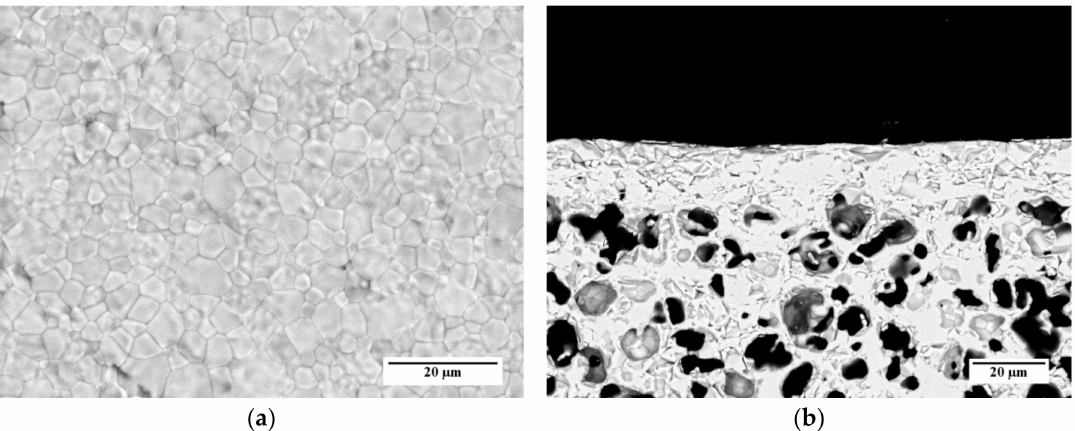
Figure 12. SEM micrographs of the membrane used for permeation tests, prepared by slurry 1 recipe and sintered by TT2 : ( a ) Aspect of the membrane layer surface; ( b )